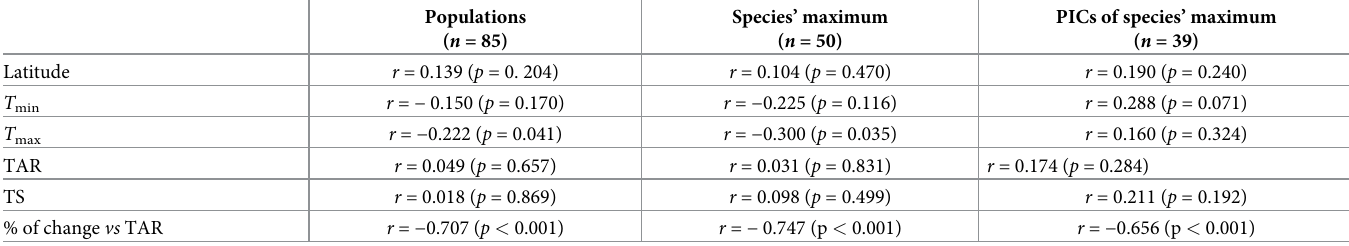
Table 1. Correlation coefficients and associated probabilities for the relationship between the index of phenotypic plasticity (PPI) for adult female size and latitude and thermal variables.